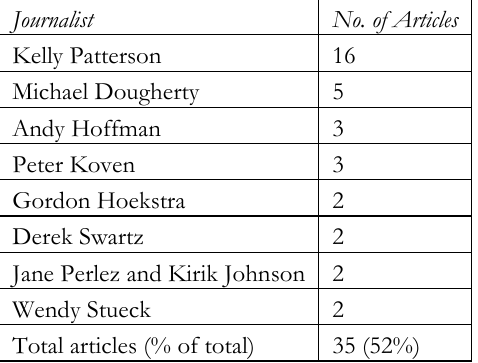
Table 2: Journalists responsible for more than one article in the sample